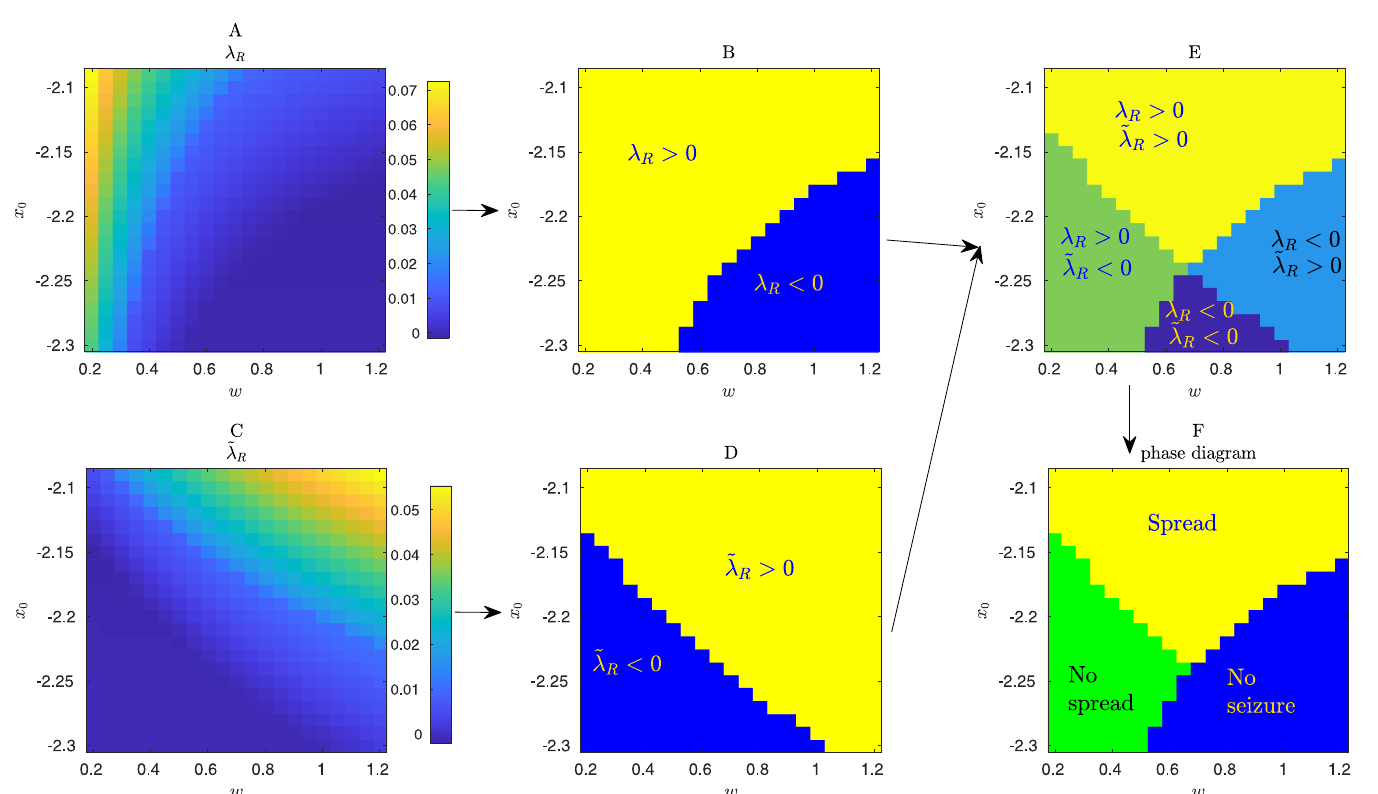
Fig 3. Schematics for the linear stability analysis of the deterministic epileptor network. Prediction of phase diagrams is based on the leading eigenvalues of two different Jacobian matrices evaluated at a given fixed point, and for a given global connectivity strength ( w ), homogeneous surrounding-node excitability ( x 0 ), patient- specific connectivity and given active EZ node. (A,B) In this case, the Jacobian matrix is derived from a network that includes the active EZ node. The term λ the real part of the corresponding largest eigenvalue of this Jacobian matrix. The fixed point of the system is stable for λ R < 0, implying no seizure will happen, and unstable (seizure) otherwise. Based on this analysis alone one cannot predict the phase diagram for the seizure spread. (C,D) In this case, the Jacobian matrix (and corresponding leading eigenvalue ~ l ), are derived from an epileptor network where the active EZ node has been removed and replaced by a constant external input to nodes connected to it. This external input is related to the average seizure activity in the active EZ node (Methods). This analysis alone also cannot predict the phase diagram, in particular the phase where seizure in the active EZ node is “inhibited” by the surrounding nodes. (E,F) The joint consideration of the signs of the leading eigenvalues of the two Jacobian matrices leads to qualitatively correct phase diagrams for seizure spread as illustrated in Fig 2. Diagrams corresponds to patient P3 and node 135 as the active EZ area ( x 0 = − 1.6). Time delays are ignored in this linear stability analysis